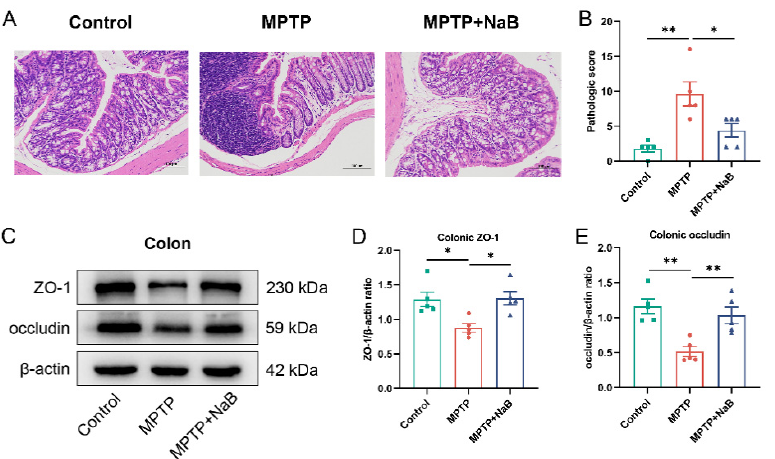
Figure 6. Sodium butyrate (NaB) ameliorates the damage to the colonic epithelial barrier in mice with 1-methyl-4-phenyl-1,2,3,6-tetrahydropyridine (MPTP)-induced Parkinson’s disease (PD). ( A ) Hematoxylin and Eosin (H&E) staining of colonic tissues. ( B ) Histology scoring for colonic sections based on HE staining. ( C ) Representative Western blotting for colonic ZO-1 and occludin expressions. ( D , E ) Band intensities of ZO-1 and occludin were quantified using ImageJ and normalized against β -actin levels. n = 5 mice per group; * p < 0.05, ** p < 0.01; data are presented as means ±SEM.